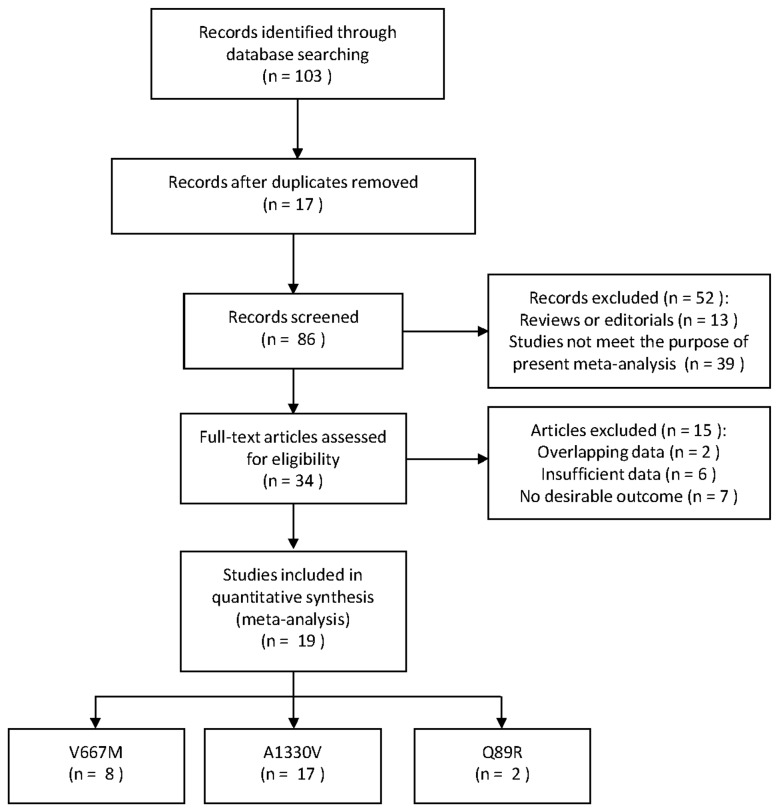
Summary of search strategy and result.